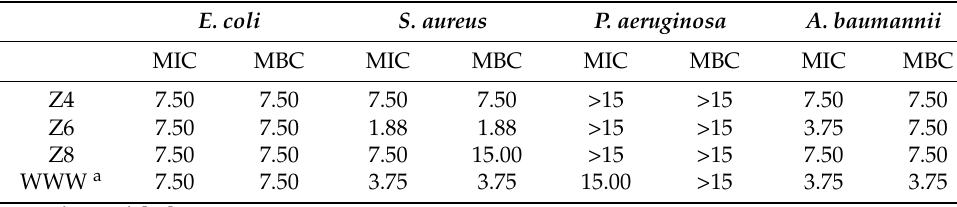
Table 2. Bacterial growth inhibition/killing concentration ( µ M).